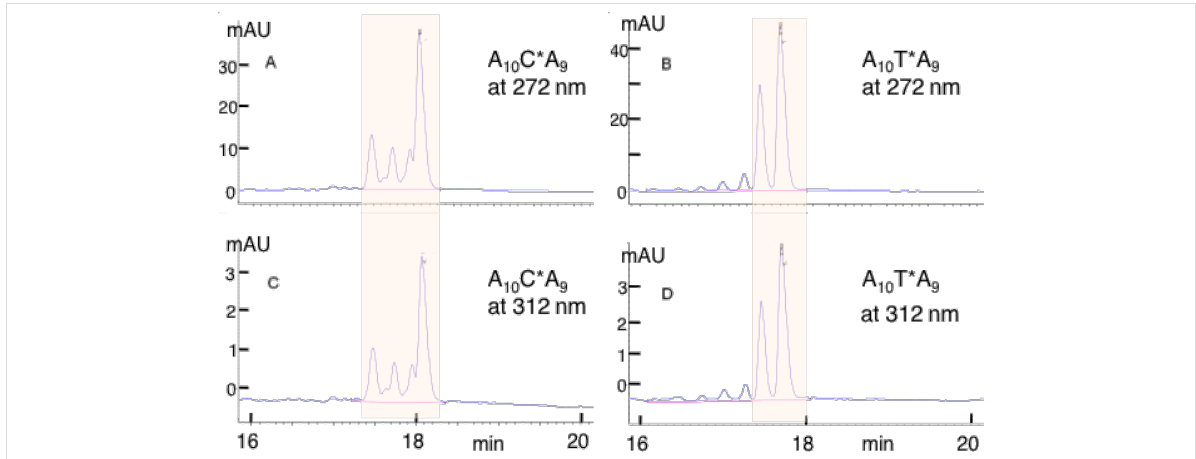
Figure 13: HPLC profiles of weeks-old-aged osmylated oligos. C* is an abbreviation for C(OsBp) and T* is an abbreviation for T(OsBp). A 10 T(OsBp)A 9 was stable over weeks at room temperature, in contrast to A 10 C(OsBp)A 9 that over time shifts materials to a new, unidentified, prod- uct (see major peak with the longest rt in (a) and (c)). Shaded areas correspond to degradation products of the C-oligo and stable osmylation prod- ucts of the T-oligo. Smaller peaks outside the shaded region correspond to osmylation products of the impurities. The figure illustrates that all the products formed by aging of C(OsBp) carry the OsBp moiety. This is evidenced by comparing the values of R = 0.11 for the C-oligo (peak area in (a) divided by the peak area in (c)) with the value R = 0.11 for the T-oligo (peak area in (b) divided by the peak area in (d)); R = 0.01 for DNA that is an order of magnitude lower compared to the reported values